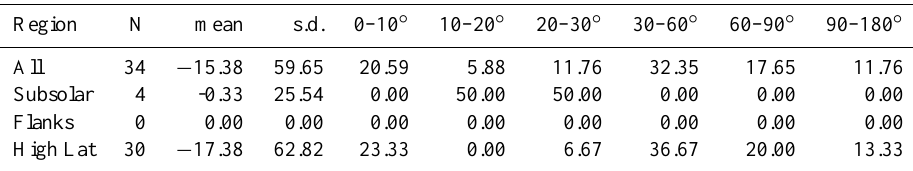
Table 15. Distribution of angular differences in the low pressure case (solar wind dynamic pressure ≤ 2nPa) for Northward IMF (IMF clock angle between − 15 ◦ and 15 ◦ ). Format as in Table